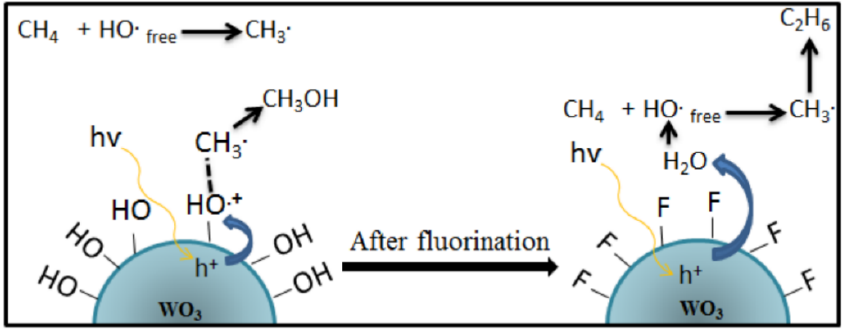
Figure 10. The reaction mechanism of photocatalytic conversion of methane to methanol on the surface of the WO 3 catalyst after fluorination [24]. Reproduced with permission from Villa et al. Copyright © 2022 Elsevier.